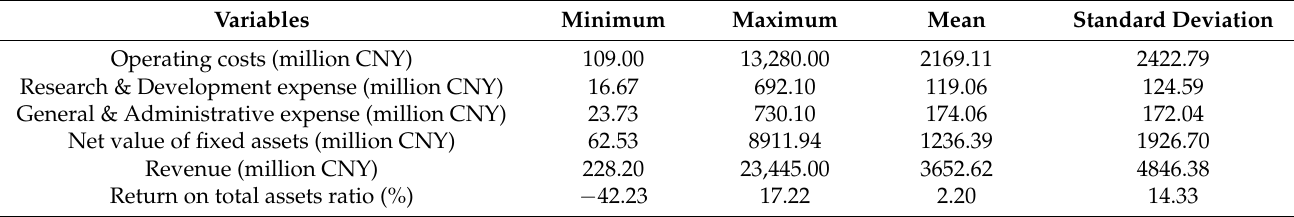
Table 5. Descriptive statistics of selected variables for 34 listed LED energy enterprises in 2018.